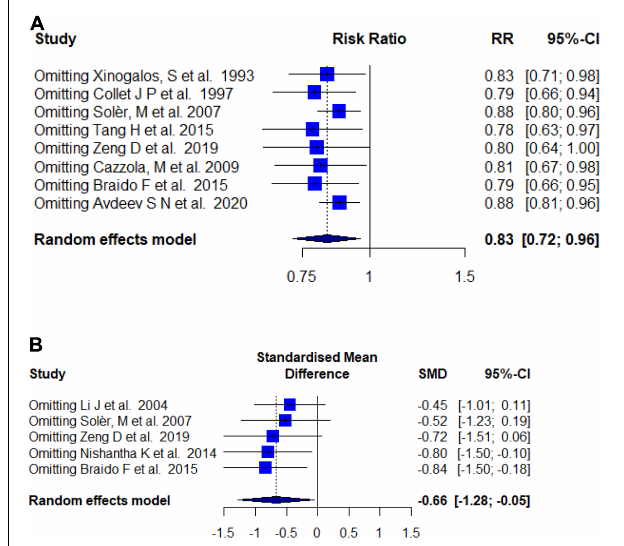
FIGURE 8 | Sensitivity analysis. (A) Influence analysis of the rate of exacerbation. (B) Influence analysis of the mean number of exacerbations.